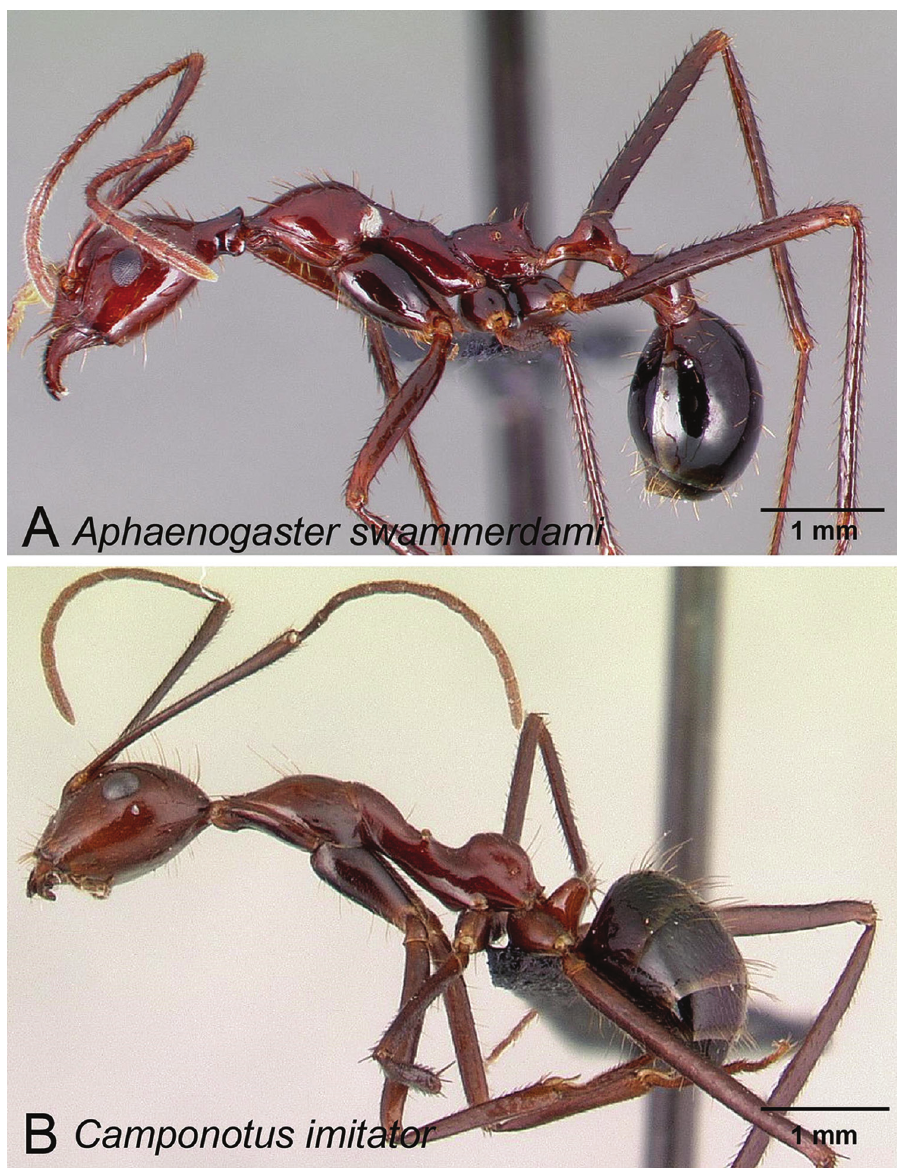
Figure 1. Camponotus species in the subgenus Myrmopytia are thought to mimic co-occurring Aphaenogaster species A Aphaenogaster swammerdami (CASENT0017663) B Camponotus imitator